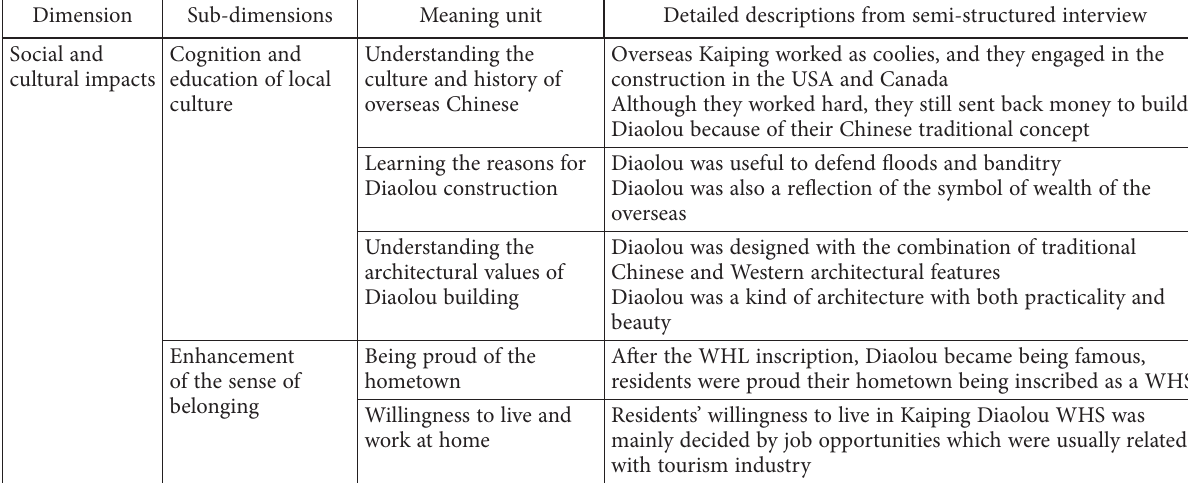
Table 3. Content analysis sample (source: authors) Dimension Detailed descriptions from semi-structured